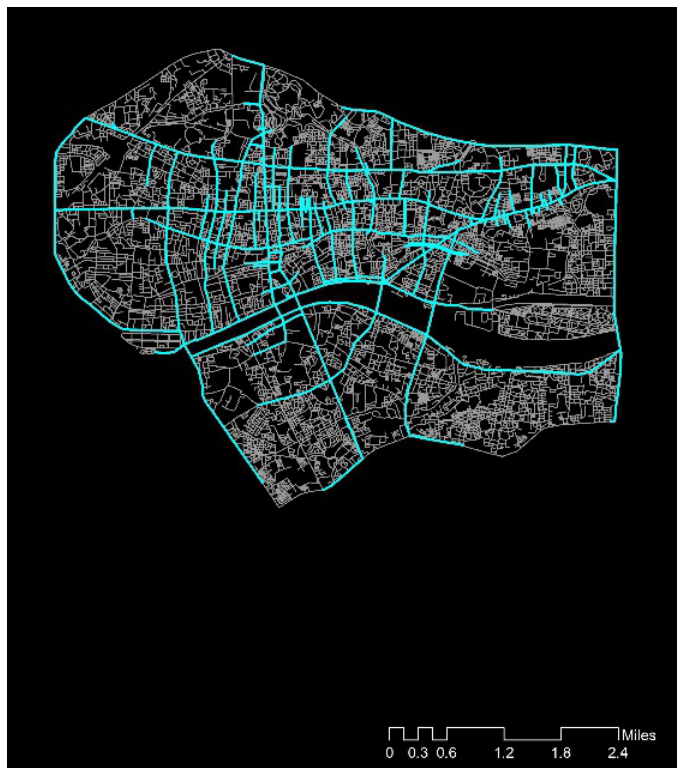
Fig. 14 Foreground network of overall